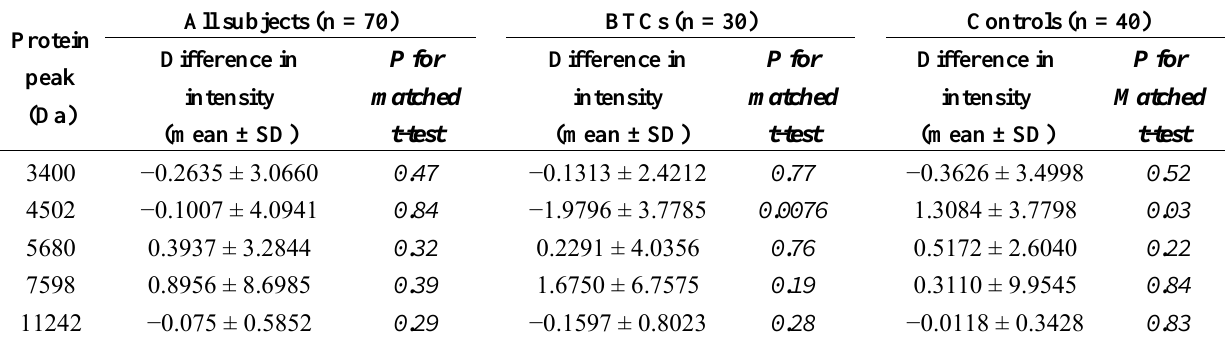
Table 6. SELDI-TOF-MS assay reproducibility of twice assays of 70 sera samples. Protein